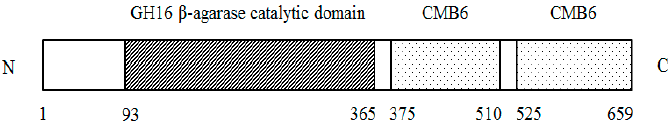
Figure 1. Schematic overview of the domain structure in AgaML. The amino acid numbers that refer to each module are indicated.